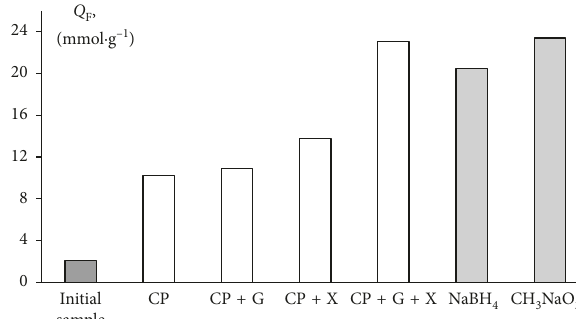
Figure 3: Equilibrium phenol vapor absorption by initial flax sample and samples after treatment by enzyme preparations and in solutions of reducers.